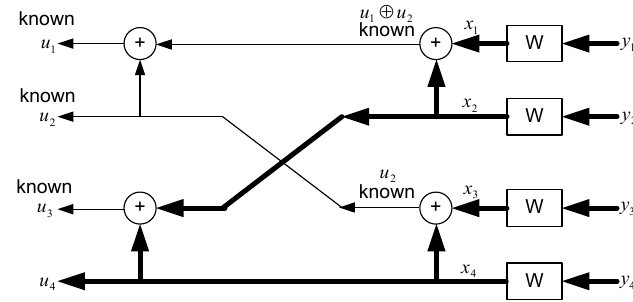
Figure 5: Decoding path of 𝑢 representation.